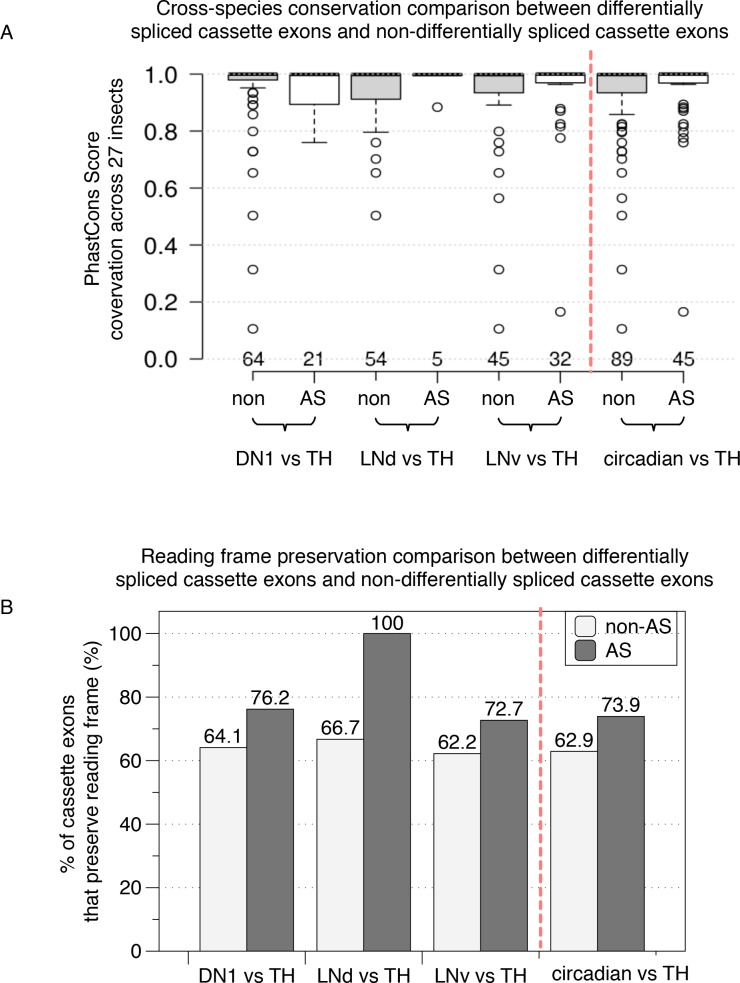
Functional comparison of differentially spliced cassette exons and non-differentially spliced cassette exons in circadian versus non-circadian TH neurons.(A) Cross-species conservation comparison. Average PhastCon scores across 27 insect species for the set of differentially spliced cassette exons (AS) and non-differentially spliced cassette exons (non) in circadian versus non-circadian neurons are plotted as a boxplot. The panels on the right of the red dashed line showing the combined differentially spliced cassette exons and non-differentially cassette exons from all three circadian neurons versus TH neuron comparisons. (B) Reading frame preservation comparison. The percentages of cassette exons that preserve reading frame when excluded/included are plotted for the differentially spliced cassette exons (AS, dark shaded columns) and the non-differentially spliced exons (non, light gray-shaded columns).